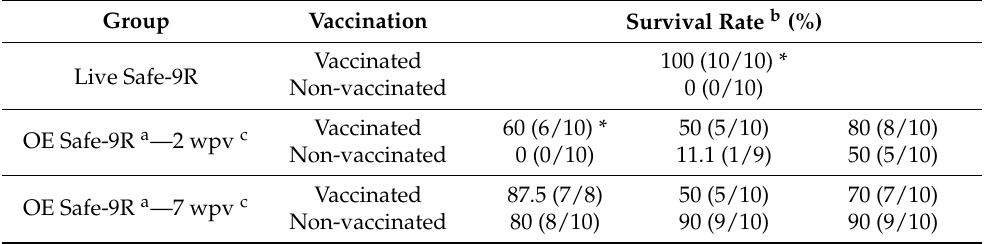
Figure 2. Comparison of stimulatory effects of knock-out mutant strains on transcriptions of pro-inflammatory cytokines and related genes in HD11 cells. Comparison of relative transcription levels of IL-1 β , IL-18, iNOS and TLR4 genes in HD11 after infection of knock-out mutant strains was performed by using the 2– ∆∆ Ct method. Statistical significance indicated as follows: ns not significant, * significantly different compared with Neg ( p < 0.05). Table 1. Protective efficacy of live and oil emulsion vaccines of